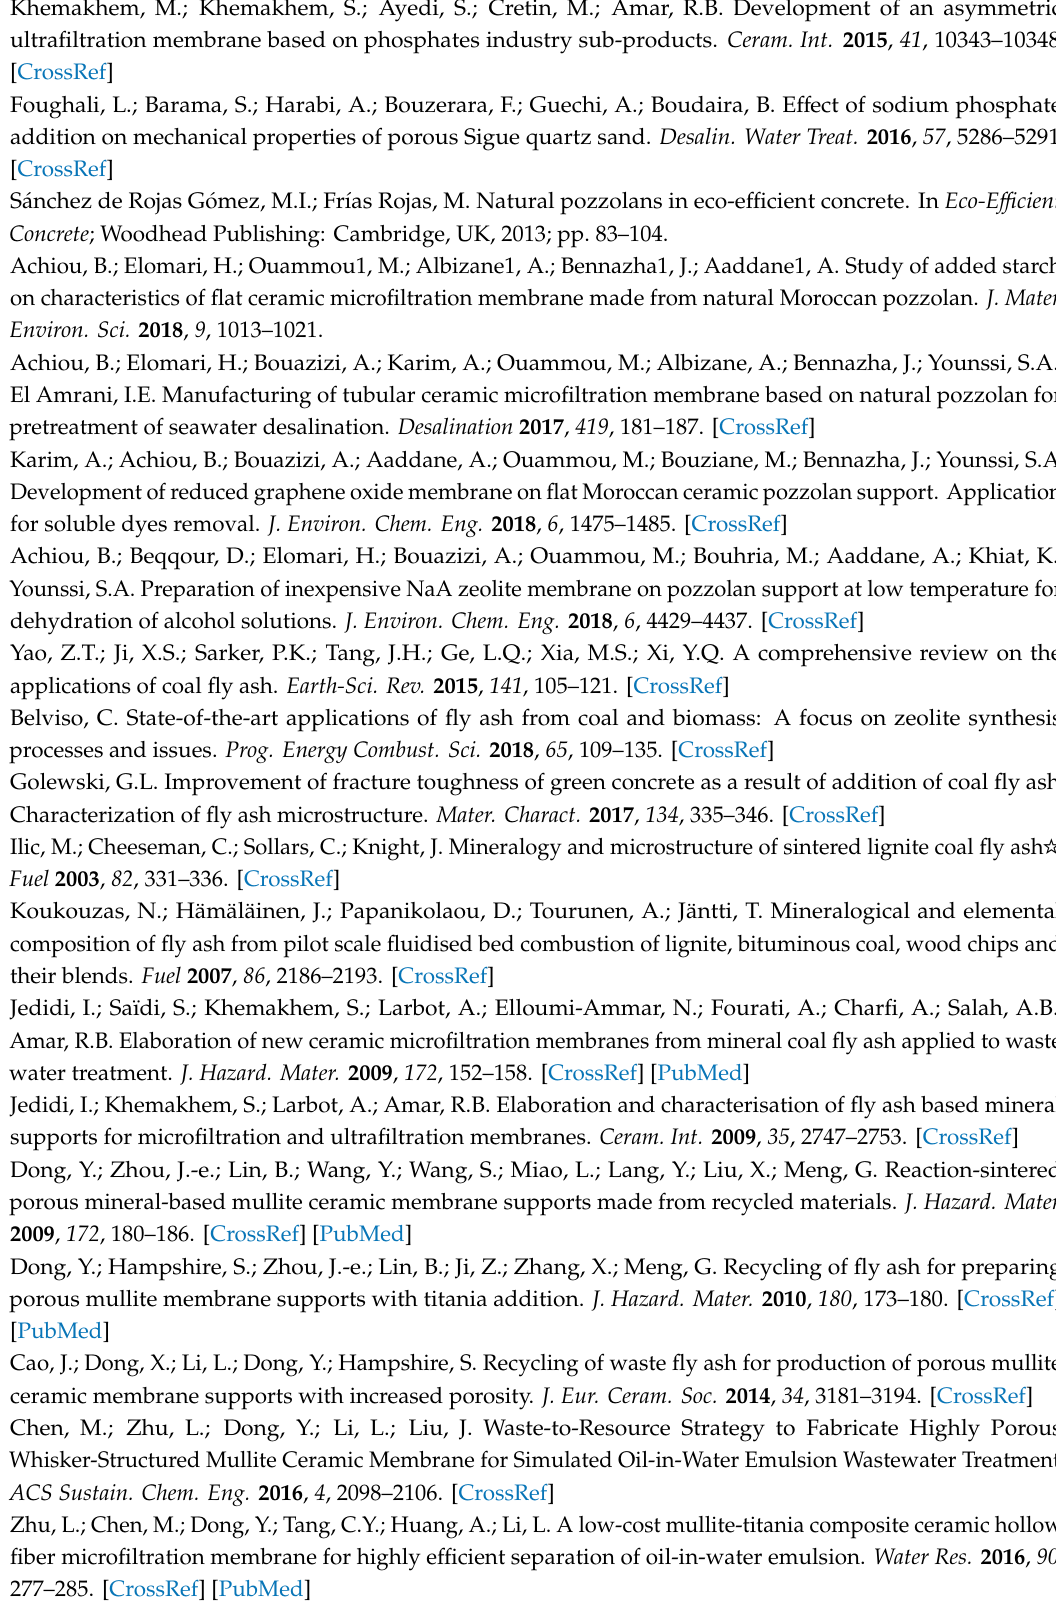
Figure 7. Comparison experimental (various light symbols for different sessions of measurements) and theoretical values (black circles, the semi-empirical theory) of the vertical derivative of the average air temperature of dT / dz in a mountain boundary layer. Sessions of measurements: ○ —27–28.07.18, □ —28.07.18, ▽ —28.07.18, ☆ —28–29.07.18, ◁ —29–30.07.18, ×—30.07–01.08.18. In the insert, the measurement session on 27 and 28 July 2018 with confidential intervals for experimental points is shown above on the left. × is the data of measurements from [10,11].